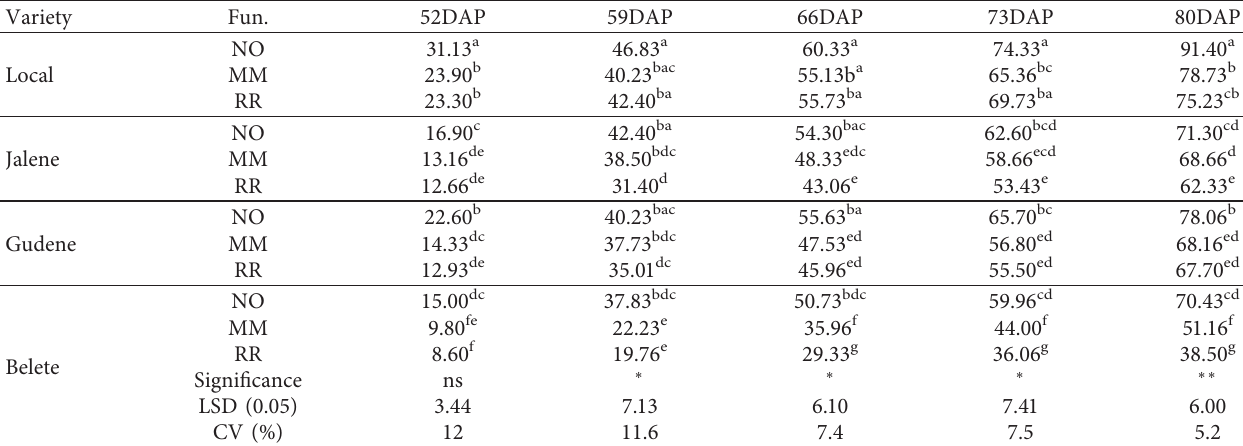
Table 2: Interaction effects of fungicides and potato varieties on late blight disease severity. Variety